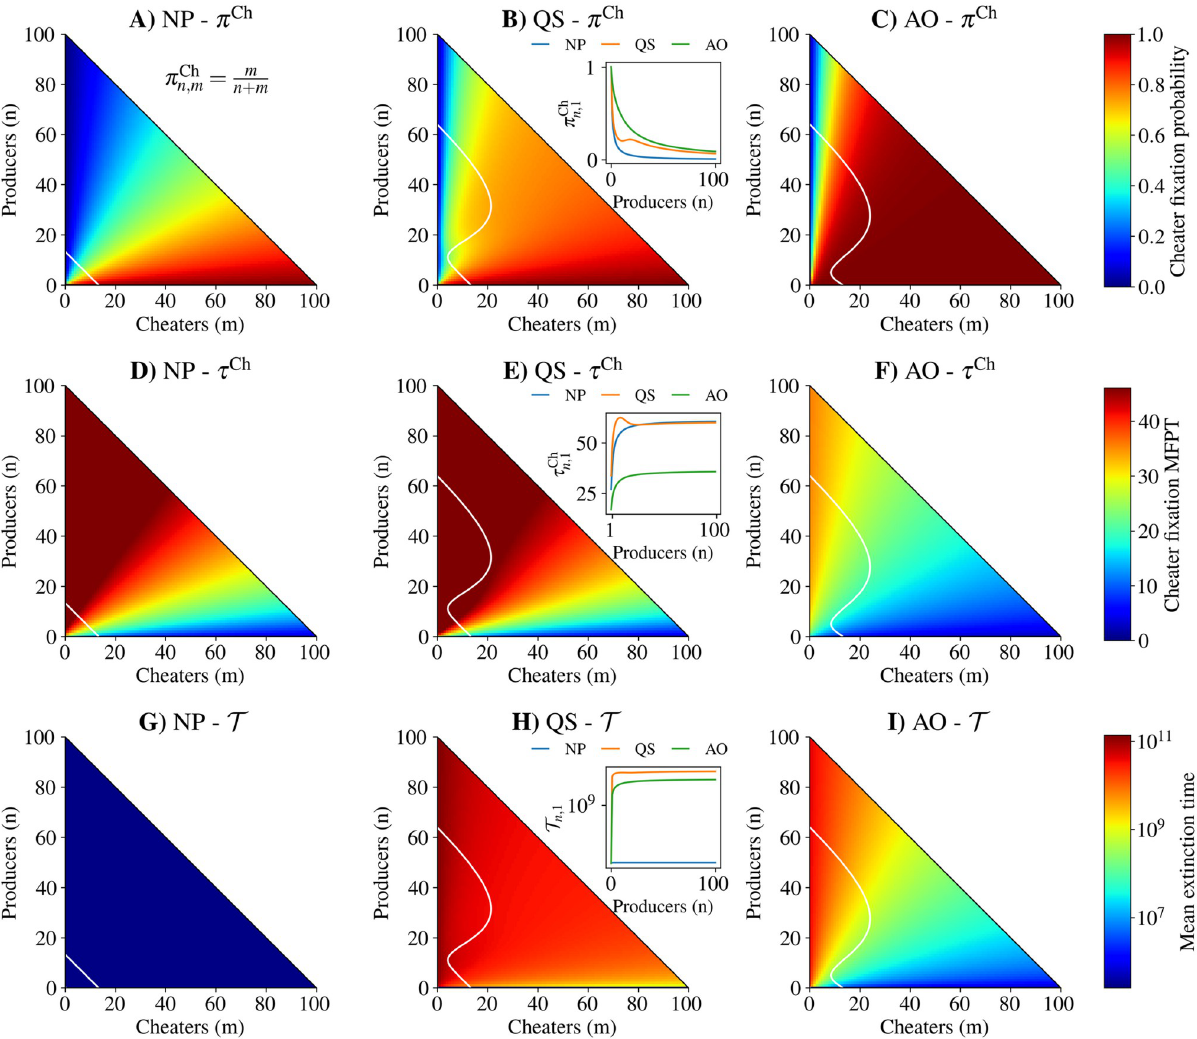
Fig 3. Quorum sensing is a constructive strategy for producers when an alternate energy source is present ( λ 0 = 0.2) and when public good cost is moderate ( c = 0.15). Row 1: Cheater fixation probability from an initial population of n producers and m cheaters for A) no production (NP), B) quorum sensing (QS), and C) always on strategies (AO). Row 2: Conditional mean first passage time to cheater fixation from initial population structure for D) no production, E) quorum sensing, and F) always on strategies. Row 3: Mean extinction time from initial population structure for G) no production, H) quorum sensing, and I) always on strategies. White traces: zero expected net total population growth contour. Inset plots in B), E), and H) show cheater fixation probability, cheater mean first passage time to fixation, and mean extinction time, respectively, for an initial population with a single cheater and n producers. See S1 Table for parameter